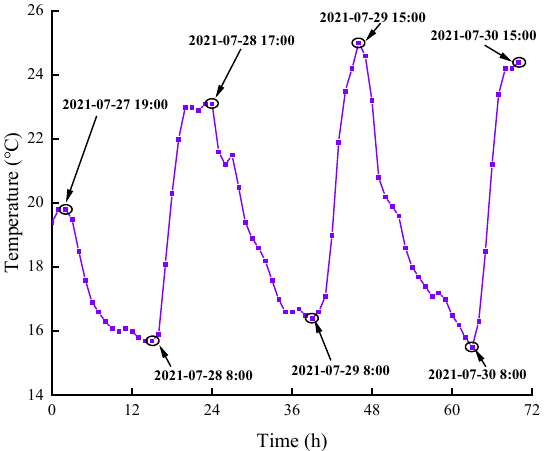
Figure 13. The shrinkage deformation curves of cement mortars with and without pretreated YDF.